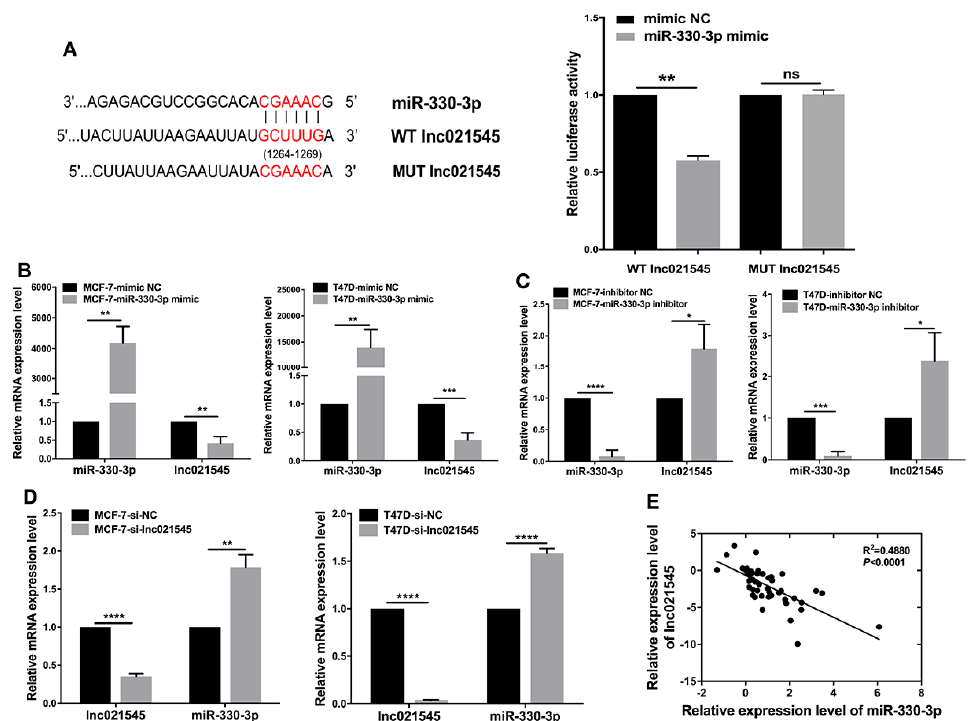
Figure 5. Lnc021545 acts as a sponge for miR-330-3p in BC cell. ( A ) The predicted and lucuferase activity assay proved binding sequences between miR-330-3p and lnc021545. Influences of miR-330- 3p overexpression ( B ) and downregulation ( C ) on lnc021545 expression in BC cells. ( D ) Influence of lnc021545 downregulation on miR-330-3p expression in BC cells. ( E ) The interrelationship of miR- 330-3p and lnc021545 expression changes in 50 BC patients’ specimens (ns: no significant different, * p < 0.05, ** p < 0.01, *** p < 0.001, **** p < 0.0001, n = 3).